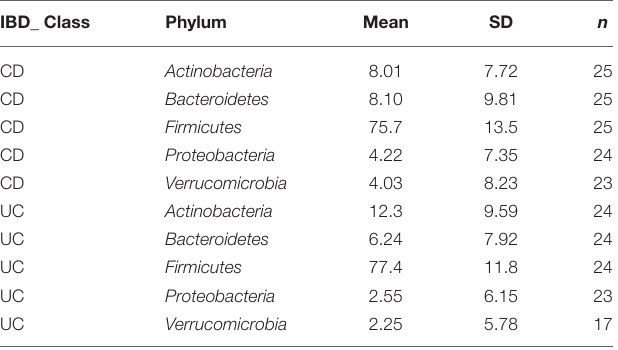
TABLE 4 | Cluster membership based on similarities found within IBD participants. Number of clusters Freq. of IBD patients in each cluster (A) Based on their baseline psychological state.